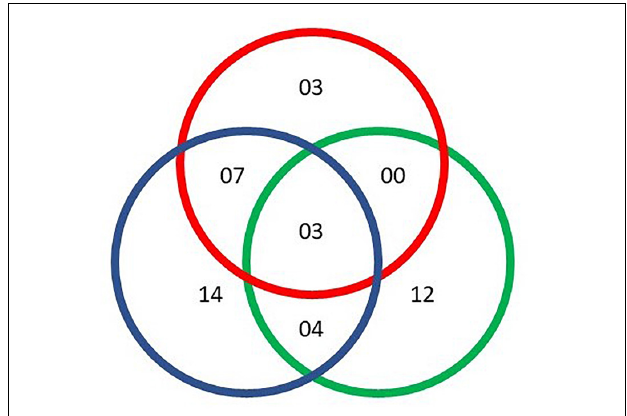
FIGURE 1 | Number of metabolites identified based on sex (green), time (blue), and time × sex (red). Each metabolite showed significant changes ( q -value < 0.05) from a two-way repeated measures